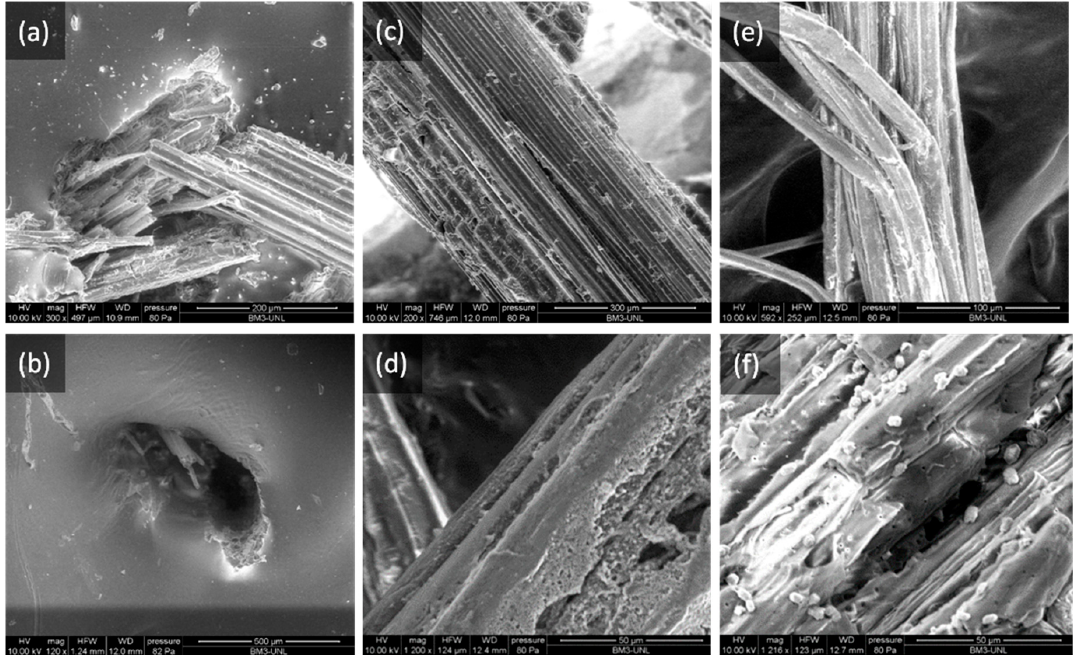
Figure 4. SEM images of ( a ) a technical bamboo fiber that broke (instead of debonding) during the pull-out test (apparent diameter of the fiber ca. 200 μ m); ( b ) the hole left in the PLA matrix by a bamboo fiber successfully pulled-out during the test (diameter of the hole ca. 500 μ m); ( c ) the surface of an untreated bamboo fiber (scale bar 300 μ m); ( d ) the surface of a mercerized bamboo fiber (scale bar 50 μ m); ( e ) the loosening of a technical bamboo fiber (bundle of elementary fibers) as a consequence of mercerization (scale bar 100 μ m); ( f ) residual salts (NaOH) left behind by mercerization in the absence of a proper washing procedure (scale bar 50 μ m).